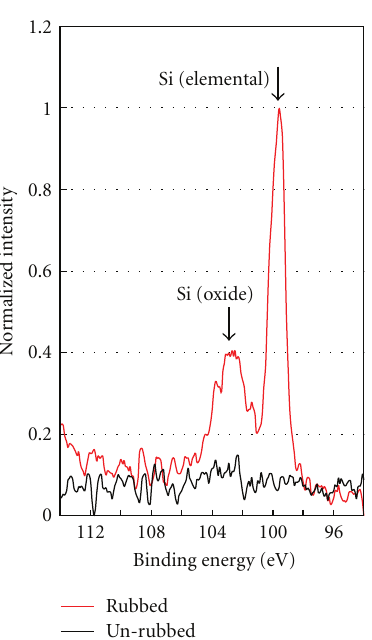
Figure 11: XPS spectrum of rubbed surface: Si 2p (GMO in PAO for